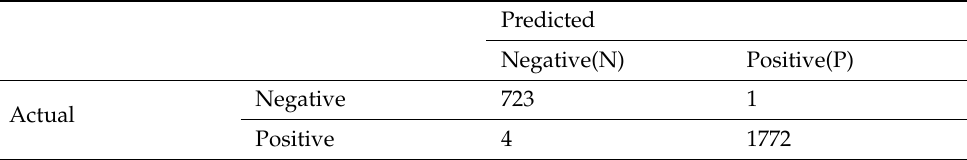
Table 1. The average of all performance metrics over the 10-fold evaluation method is given in Table 2. In all the models mentioned above, a dropout of 0.75 was applied to the hidden layers to avoid overfitting. The loss of the model has been calculated using the log loss method. In the fully connected dense layer, the SoftMax activation function was used to perform the classification work. To visually interpret the results, the following graphs were plotted. In the first instance, a Deep Convolutional neural network was coupled with a Multilayer Perceptron model on the normalized EEG lengths of 1 s, 2 s, and 4 s. The model produced an accuracy of 96.2% on 2-s EEG length, 97.7% accuracy on 2-s EEG length, and 98.1% accuracy on 4-s length EEG. The same data produced accuracies of 97.3%, 98.5%, and 98.5% on the model, based on the Deep Convolutional Autoencoder model and coupled with Multilayer Perceptron, on EEG lengths of 1 s, 2 s, and 4 s, respectively. Table 1. Confusion matrix. Predicted